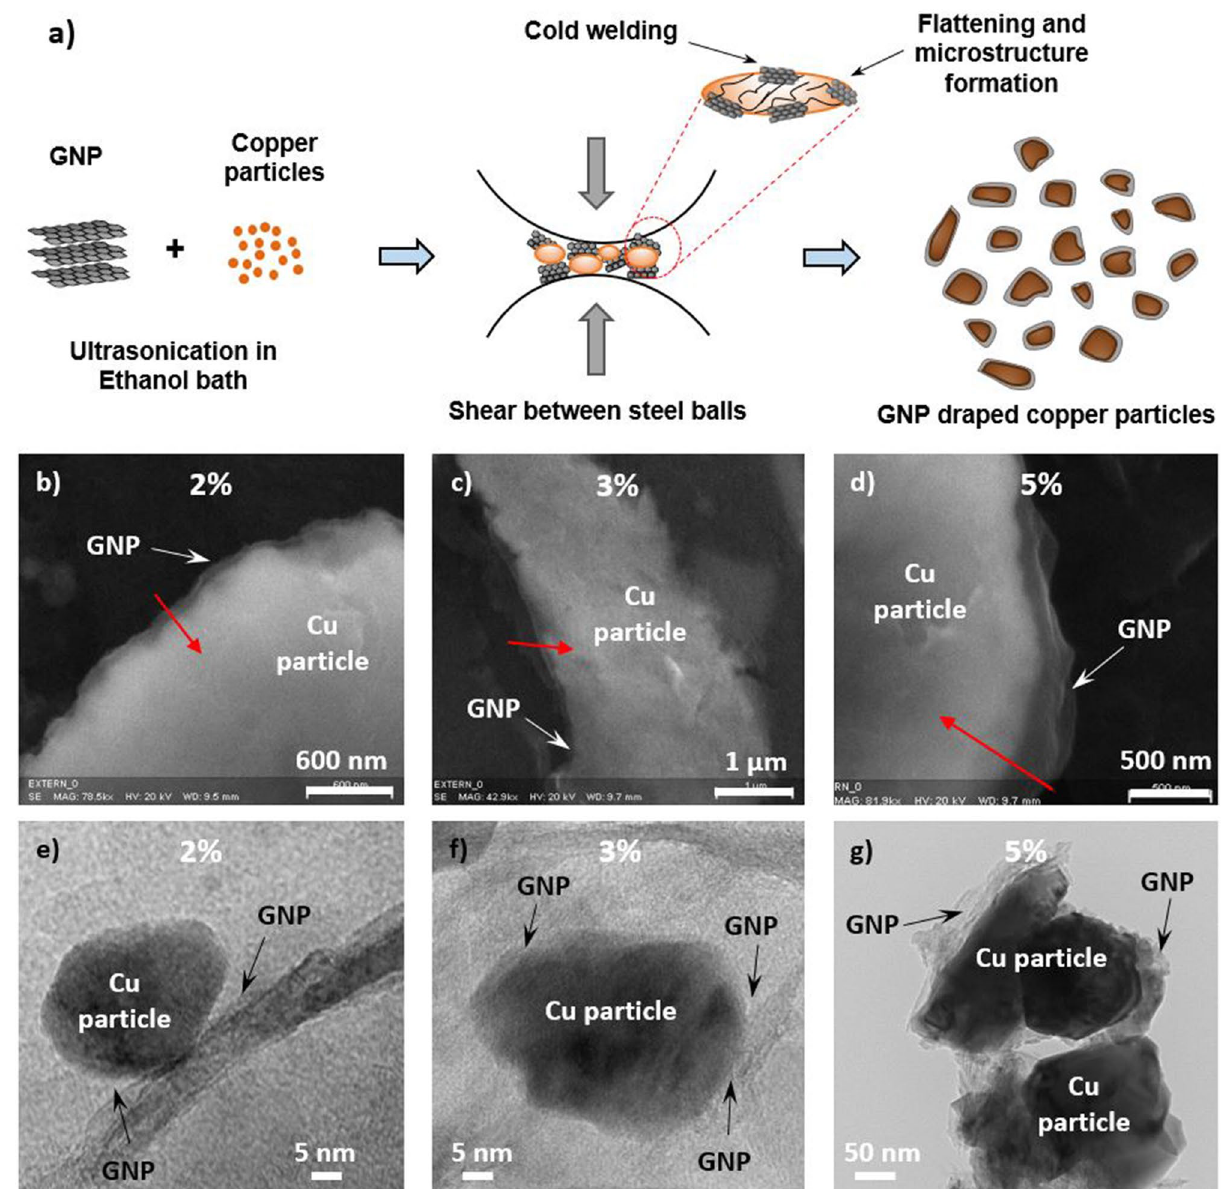
Figure 1. GNP draped copper particles via ball milling, Scanning and transmission electron microscopy images of 45 µm ( b , c , d ) and 20 µm ( e , f , g ) copper particles draped with 2% GNP, ( b , e ), ( b ) 3% GNP ( c , f ), and ( c ) 5% GNP ( d , g